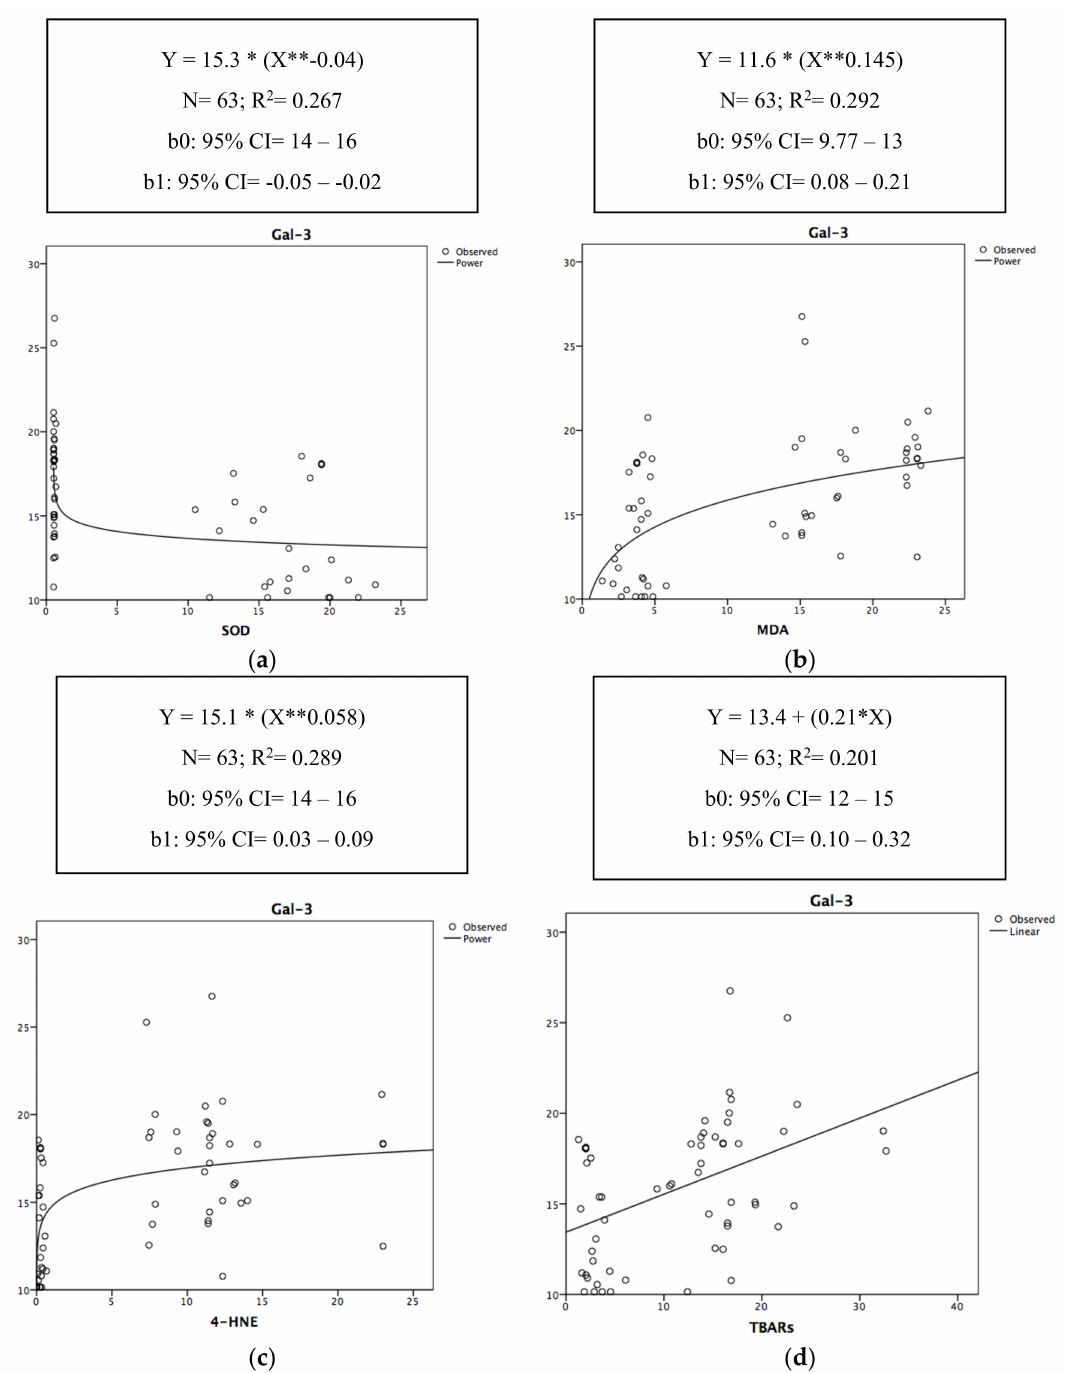
Figure 3. ( a – d ) Non-linear scatter diagrams of the determination between Gal-3 and SOD ( a ), MDA ( b ), 4-HNE ( c ), TBARs ( d ). R 2 = the value of R 2 (in terms of percentage) expresses the percentage of the variability of the outcome (Gal-3) that can be explained by the predictor. *: the asterisk in the curve equation equals to the “ × ” sign of multiplication. **: the two asterisks in the curve equation equals to “X”